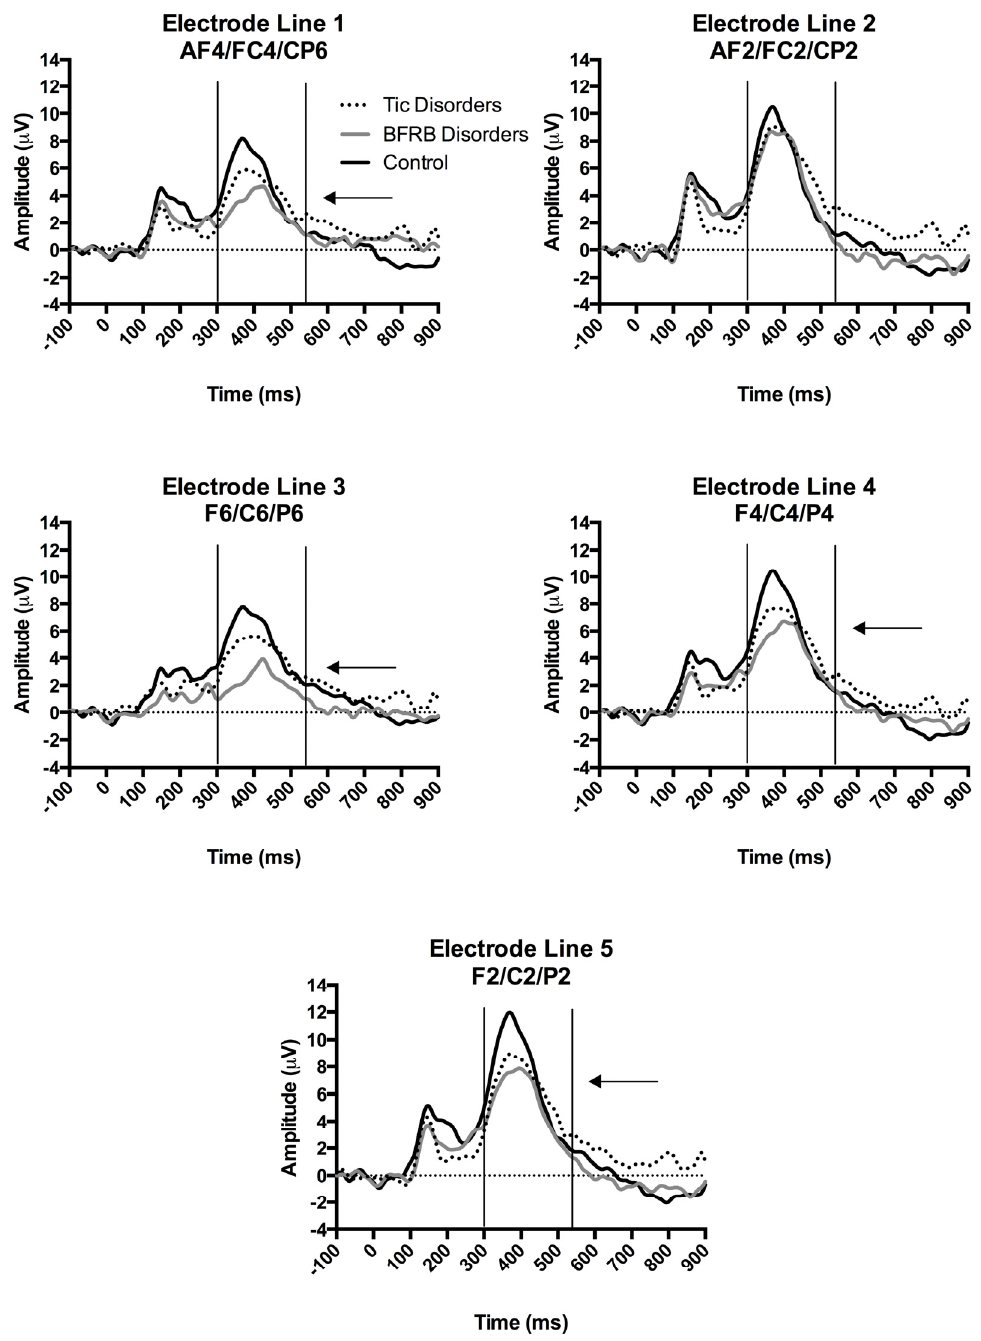
Figure 1. ERPs in the rare condition over the right hemisphere according to a division by electrode line. The x-axis represents the amplitude ( μ V) and the y-axis represents the time in milliseconds. The ERPs were time-locked to the stimulus onset. The P300 was measured from baseline-to-peak between 300–550 ms post-stimulus onset. Arrows show significantly smaller P300 voltages for BFRB patients compared to control participants over the first, third, fourth and fifth electrode lines.